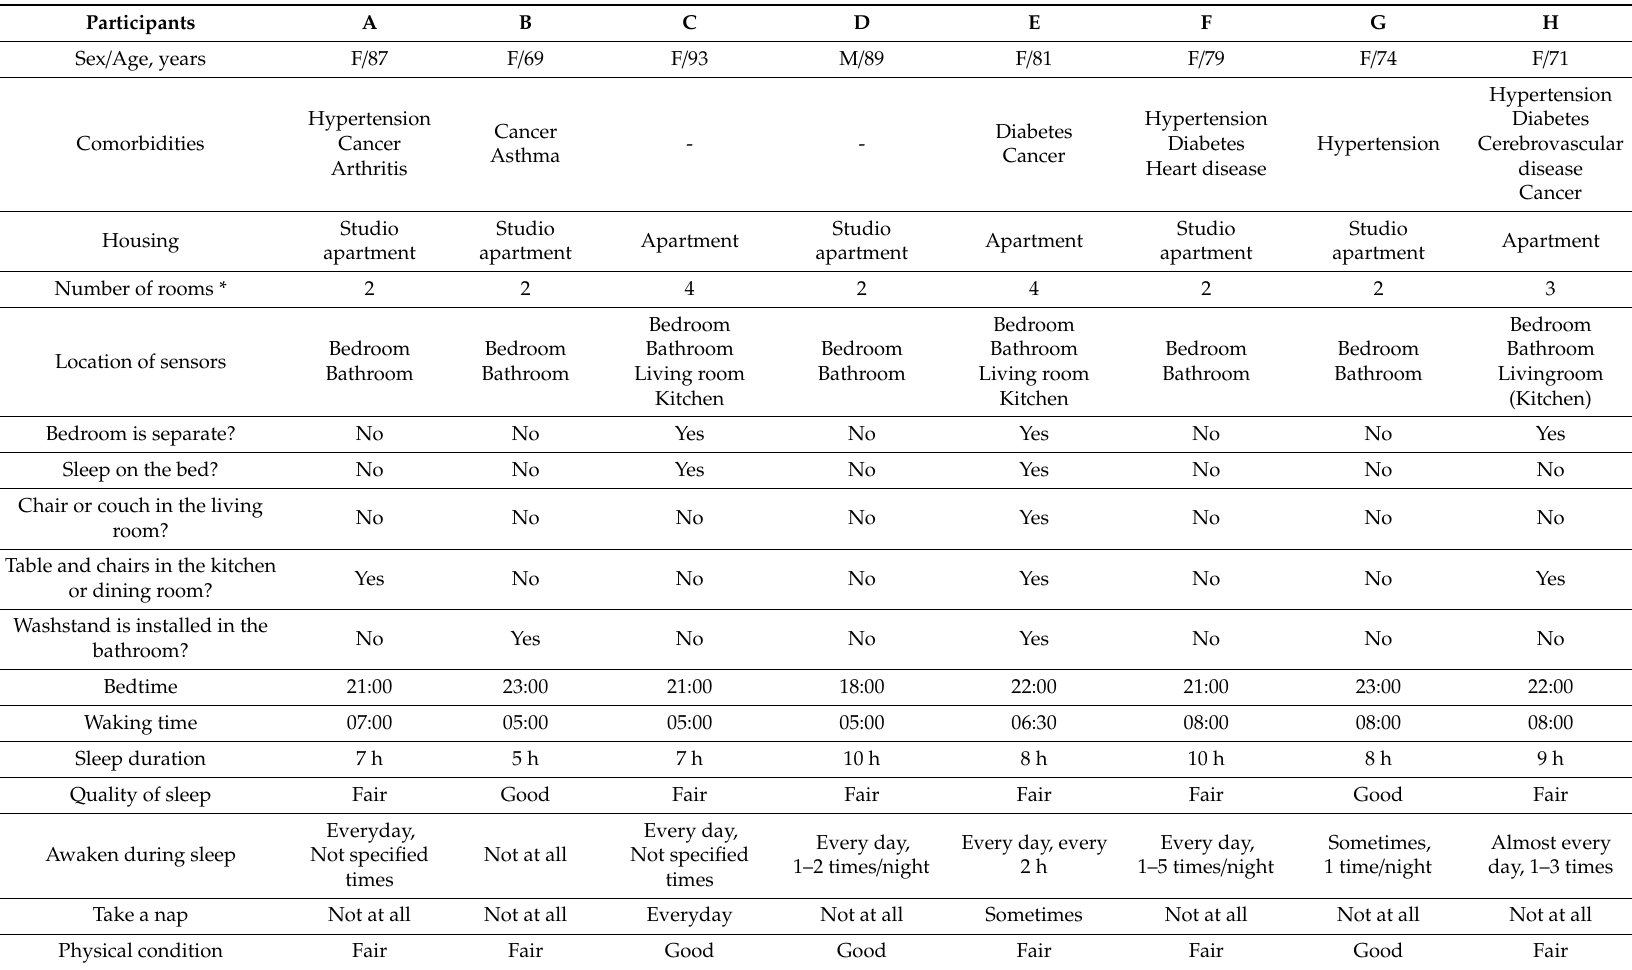
Table 1. Baseline characteristics of older adult